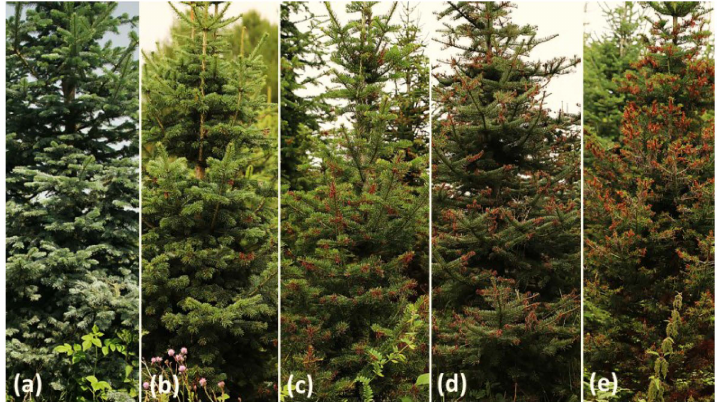
Figure 2. In 2013, ratings of disease severity caused by Delphinella abietis (scale from 0 to 4) on subalpine fir ( Abies lasiocarpa ) were carried out in the provenance trial at Jønsberg ( a ) 0% damage; ( b ) 1%–20% damage, ( c ) 21%–60% damage; ( d ) 61%–100% damage; and ( e ) 61%–100% damage of current year shoots in addition to damage in previous years. Photos: Odd Ragnar